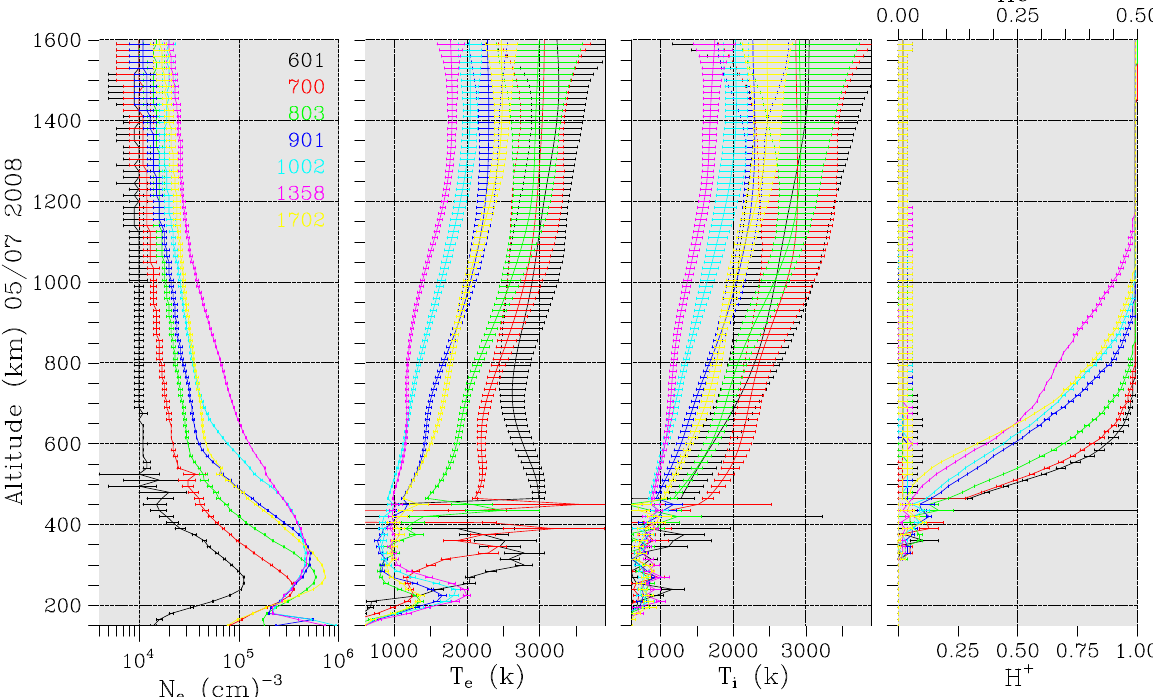
Fig. 4. Variations in ionospheric state parameters as a function of local time on 7 May 2008. The curves are based on 10-min. incoherent integrations. The four columns represent, from left to right, plasma number density, electron temperature, ion temperature, and light ion fraction. Long-pulse (double pulse) data are used for parameter estimation above (below) 450km altitude. Data quality below 450km altitude is poor in the early morning hours when plasma density is